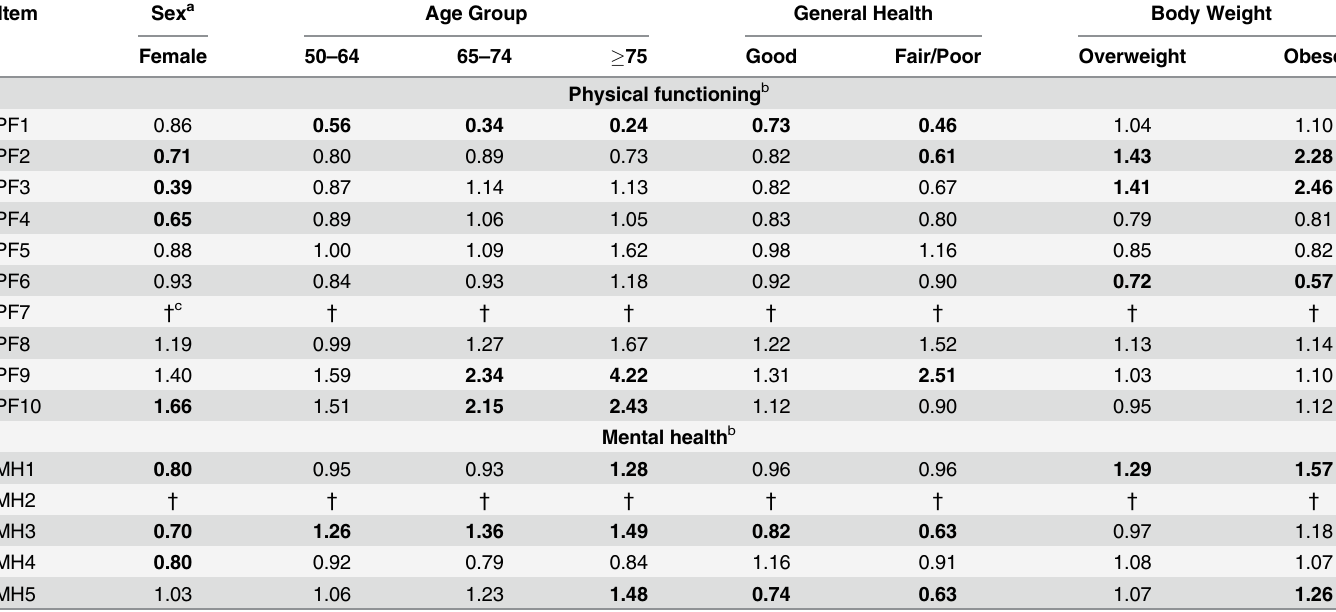
Table 3. Odds ratios for differential item functioning (i.e., direct) effects on the SF-36 physical functioning and mental health sub-scale items in the Canadian Multicentre Osteoporosis Study. Item Sex a